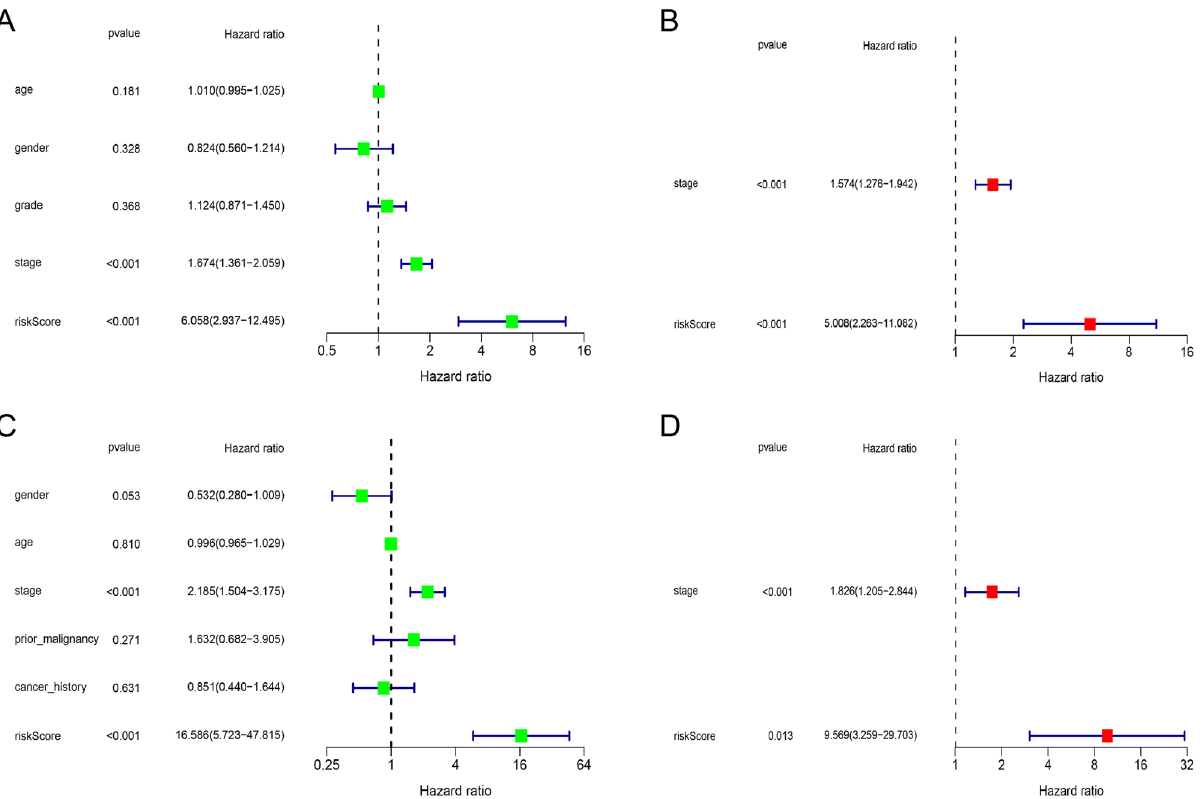
Figure 4. Independent predicting power of BA-related model. ( A , B ) Forest plots of Cox regression analysis results in TCGA cohort. ( C , D ) Forest plots of Cox regression analysis results in ICGC cohort.